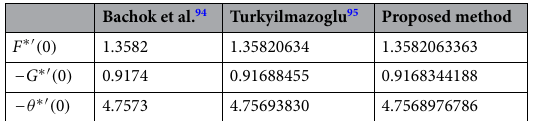
Table 2. A comparison of the F ∗′ ( 0 ) , − G ∗′ ( 0 ) and − θ ∗′ ( 0 ) on static Pr = 6.2 through Refs. 94,95